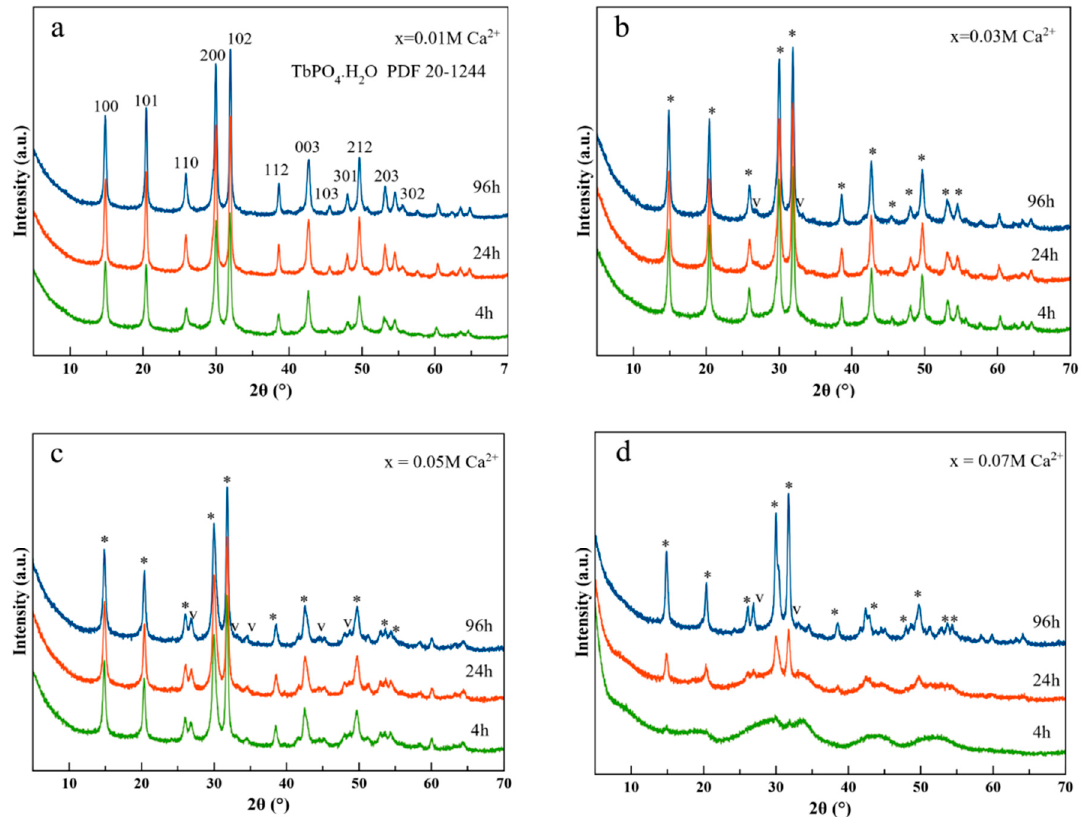
Figure 1. Evolution of XRD patterns with maturation time (4 h, green; 24 h, red; 96 h, blue) of samples precipitated from Ca 2+ /Tb 3+ /cit/phosphate/carbonate solutions in presence of increasing concentrations of Ca 2+ : ( a ) x = 0.01 M Ca 2+ ; ( b ) x = 0.03 M Ca 2+ ; ( c ) x = 0.05 M Ca 2+ , and ( d ) x = 0.07 M Ca 2+ . * hexagonal phase TbPO 4 ·nH 2 O PDF 20-1244.